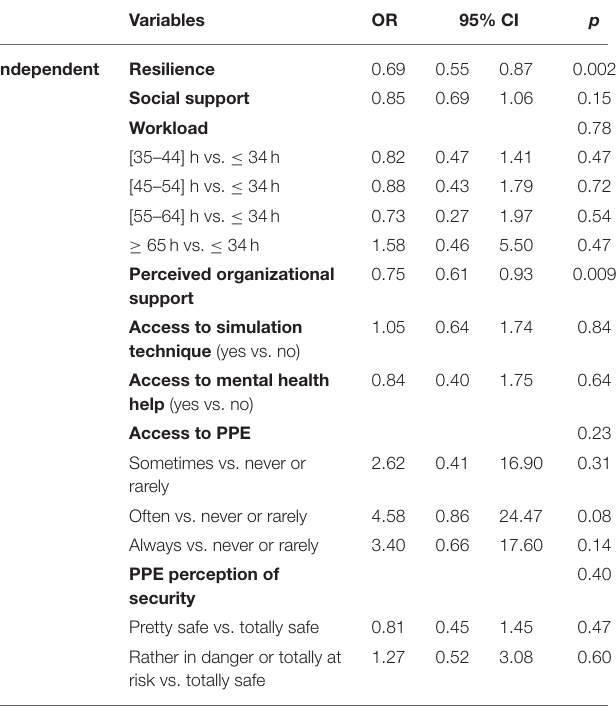
TABLE 3 | Adjusted odds ratios, 95% confidence interval and p -values from multivariable logistic regression analysis for burnout among healthcare workers ( n =